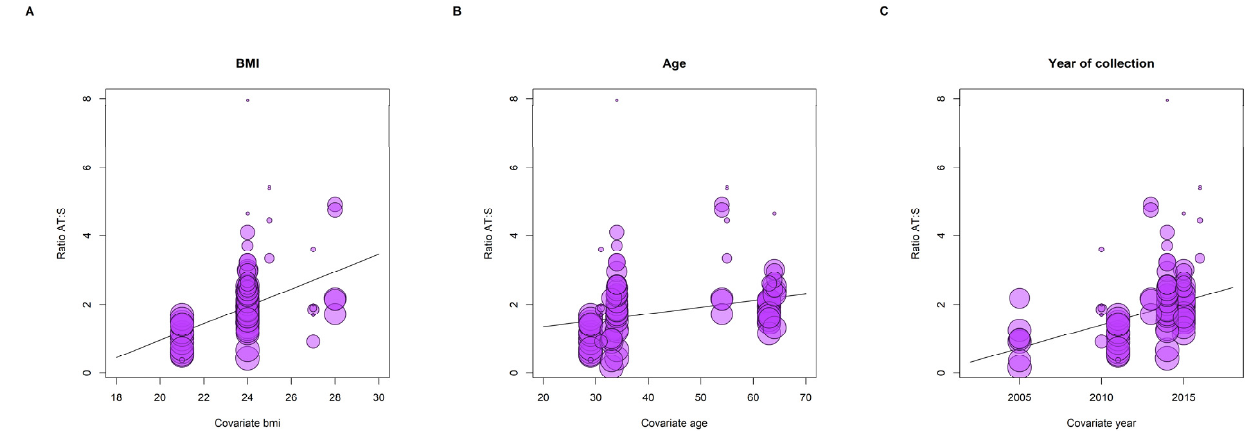
Figure 3. Bubble plots representing the associations between adipose tissue: serum ratios with body mass index (BMI, ( A )), age ( B ), and year of collection ( C ) from the random effects meta-regression model. The study [52] was excluded from this analysis because the BMI was not reported.